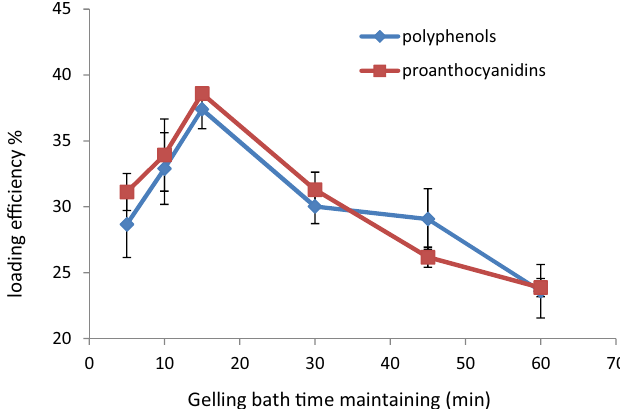
FIGURE 4 - Effect of gelling bath time maintaining on total extractable polyphenols and proanthocyanidins loading efficiency. a Values are mean ± SD, (n =